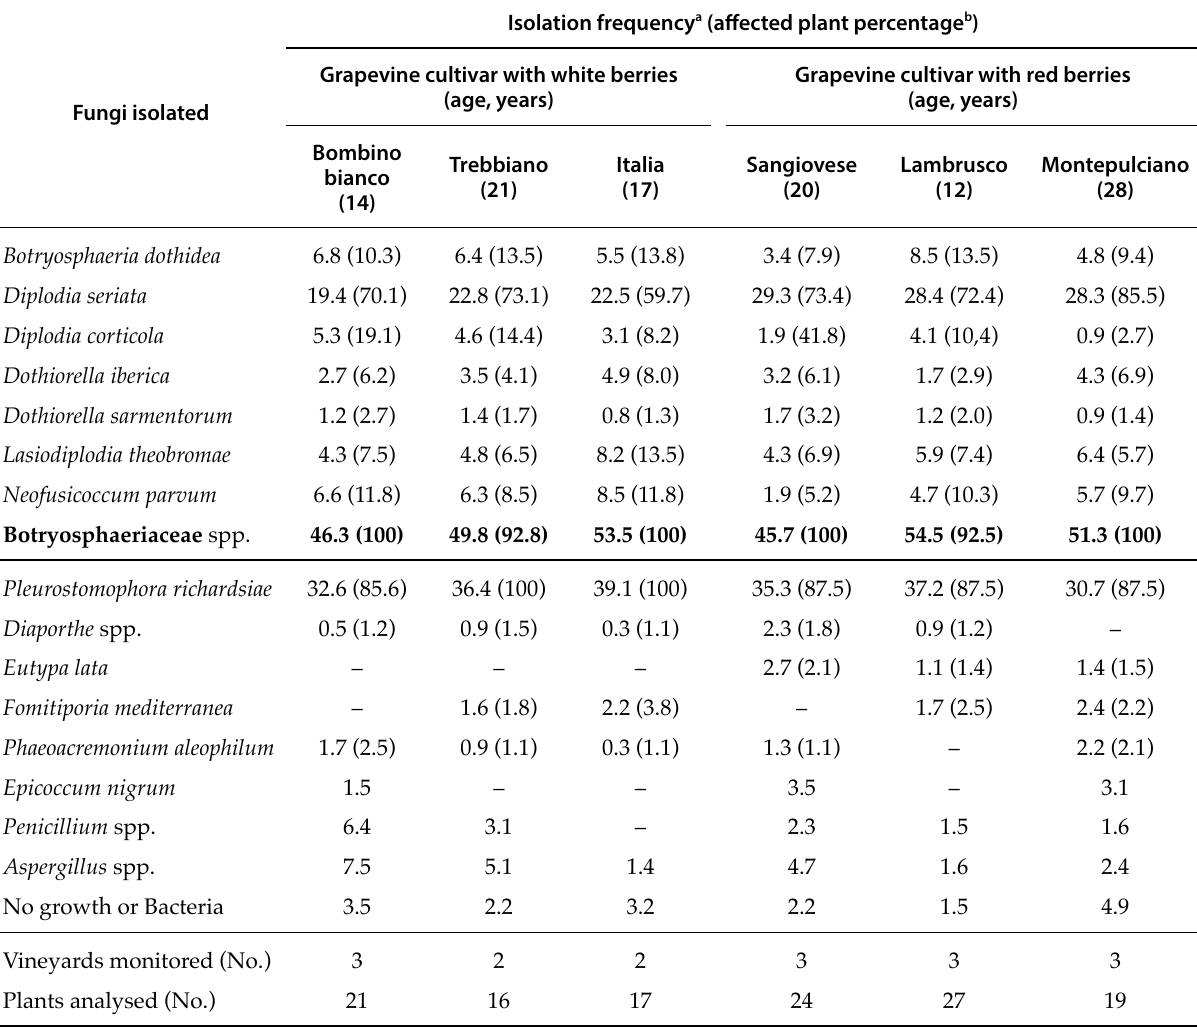
Table 1. Isolation frequency (and affected plant percentage) of fungi isolated from grapevine plants of six cultivars.